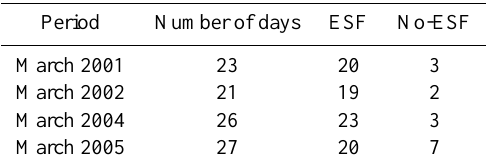
Table 2. Number of days considered in each year along with num- ber of nights with ESF and without